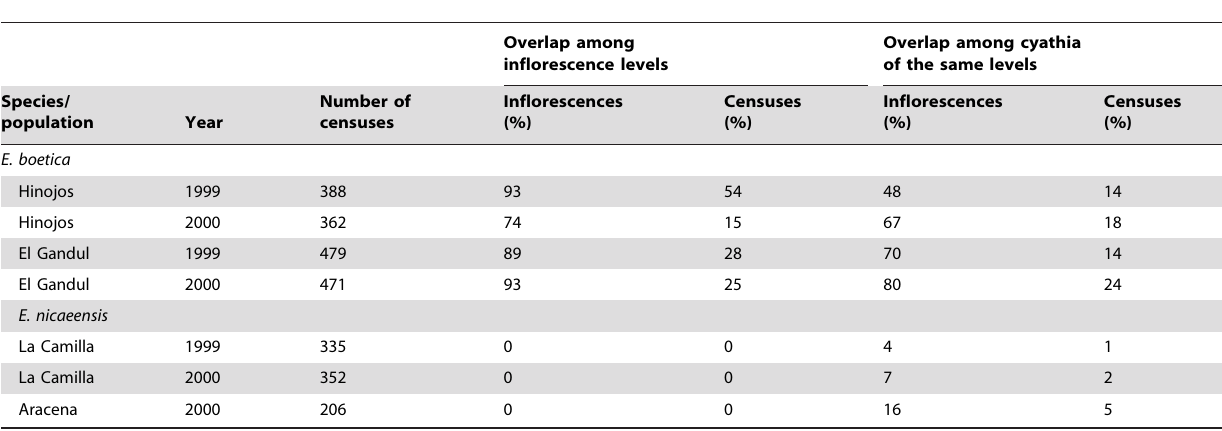
Table 2. Flowering overlap among inflorescence levels and among different sexual phases of cyathia of the same inflorescence level of Euphorbia boetica and E. nicaeensis.